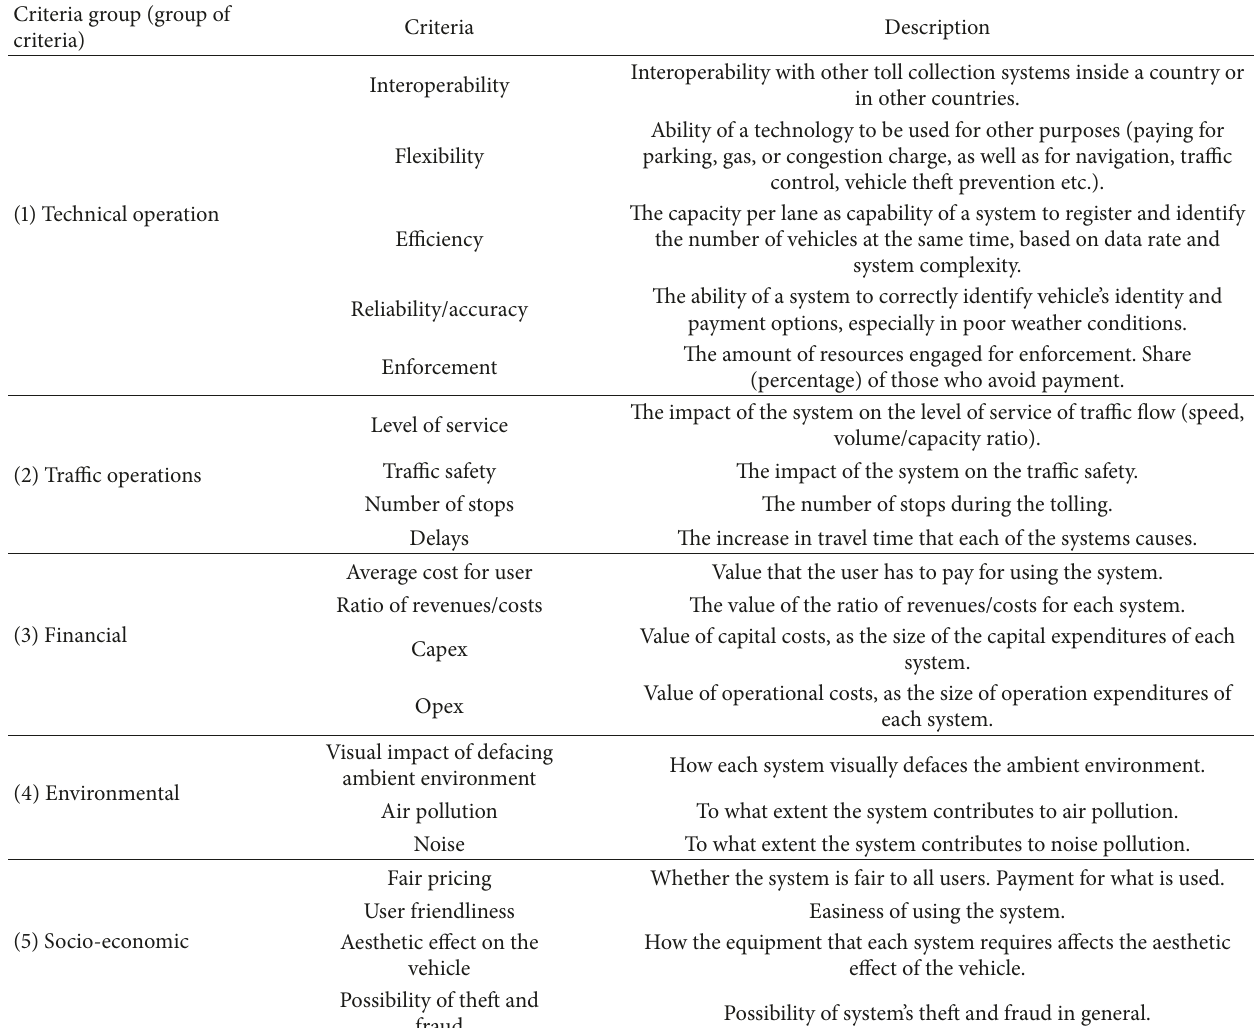
Table 4: Groups of criteria and description of criteria.